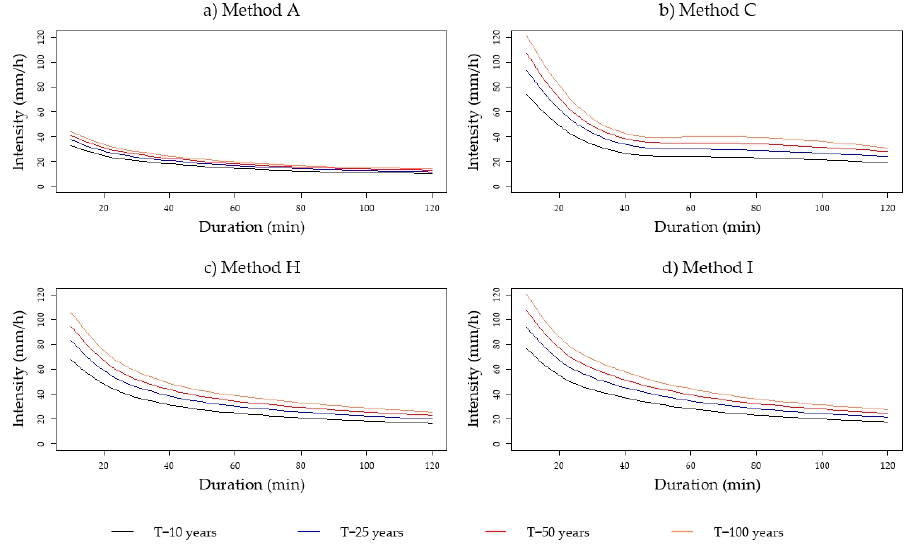
Figure 7. Established comparison of the IDF relationship estimated through di ff erent methods for station 2036 for di ff erent return periods. ( a ) shows the IDF curves from method (A), estimated from pluviograph records using Gumbel (Equation (1)). ( b ) shows the IDF curves from method (C) estimated from isohyetal map of the SCT. ( c ) shows the IDF curves from method (H) estimated from the average of IDF developed by methods A, B, C, D, E, and F, and ( d ) shows the IDF curves from method (I) estimated from Chen equation using the ( R ) ratio proposed (Equation (8)).